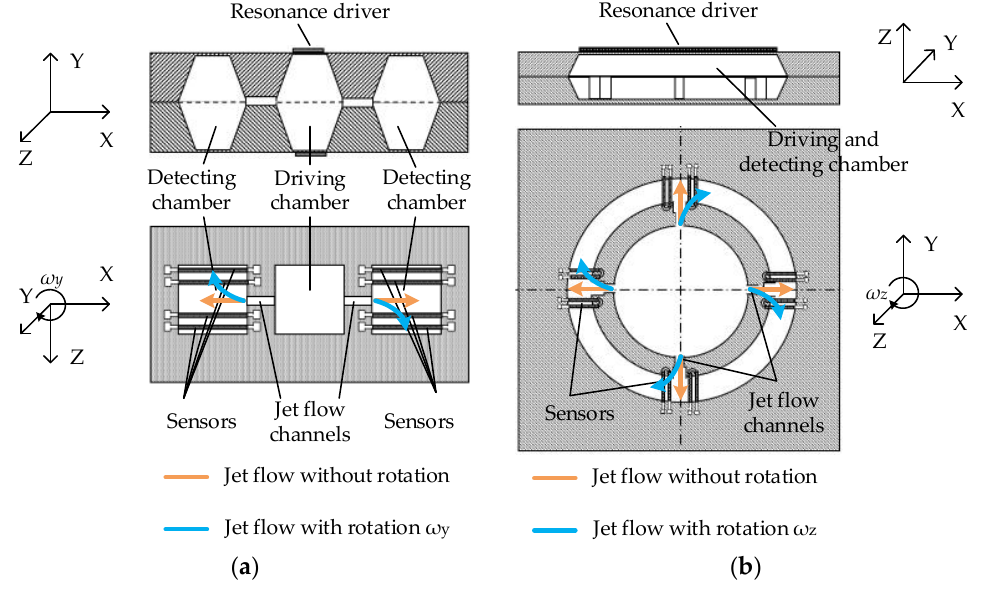
Figure 9. Monolithic uniaxial jet flow gyroscopes, ( a ) using three micro chambers [63]; ( b ) using only one chamber [111].